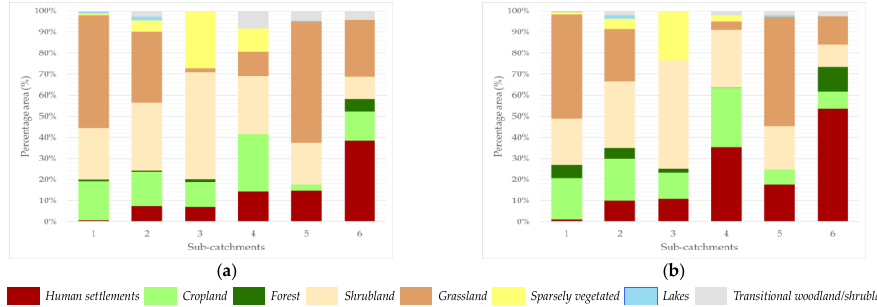
Figure 5. Cumulative percentage area of different land use types in sub-catchments 1–6 in the Rocha River catchment in ( a ) 1997 and ( b ) 2017.